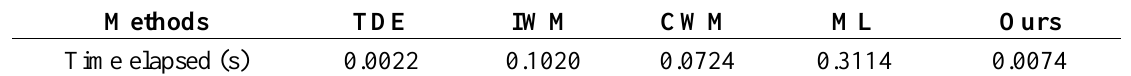
Table 5. Time elapsed for different